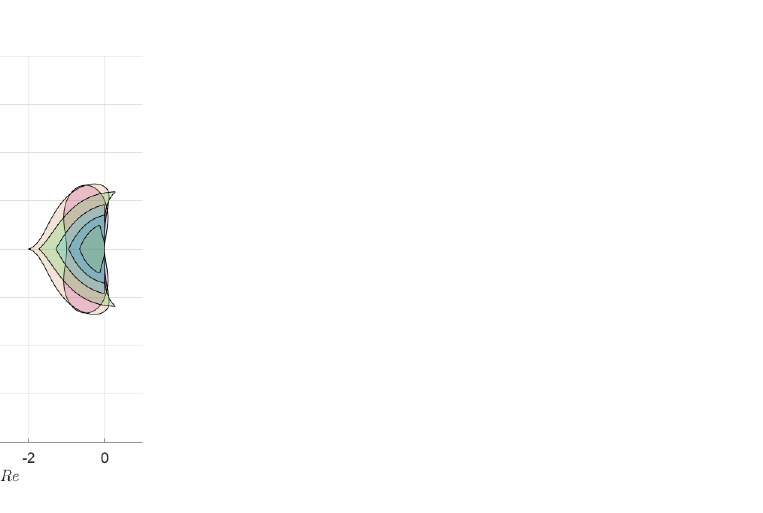
Figure 4. Stability regions of the semi-implicit ABM method for k = [ 0,0.5,1 ] (from left to right).